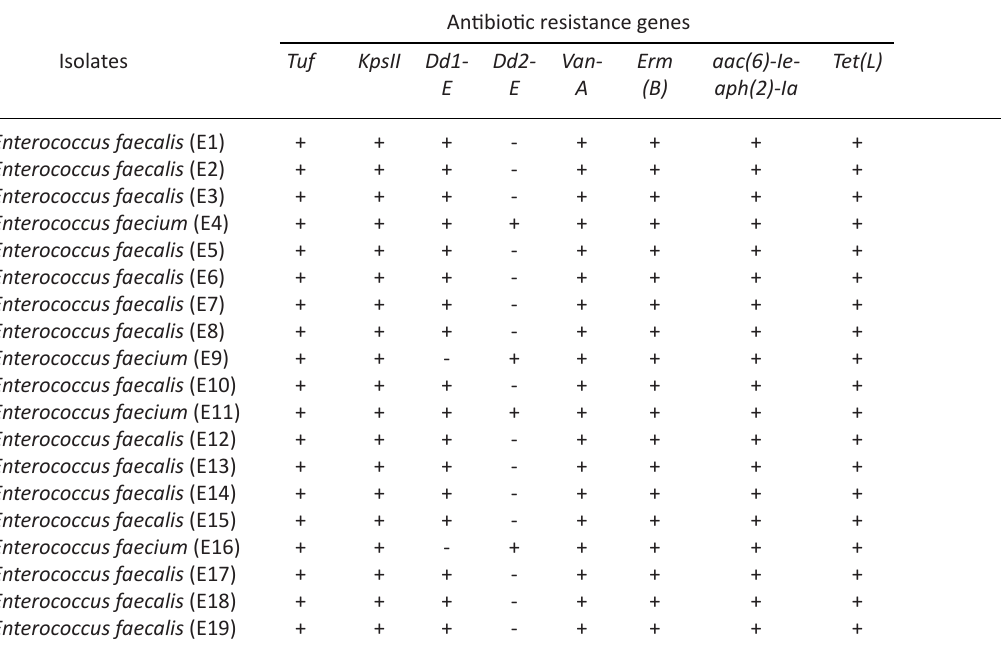
Antibiotic resistance genes